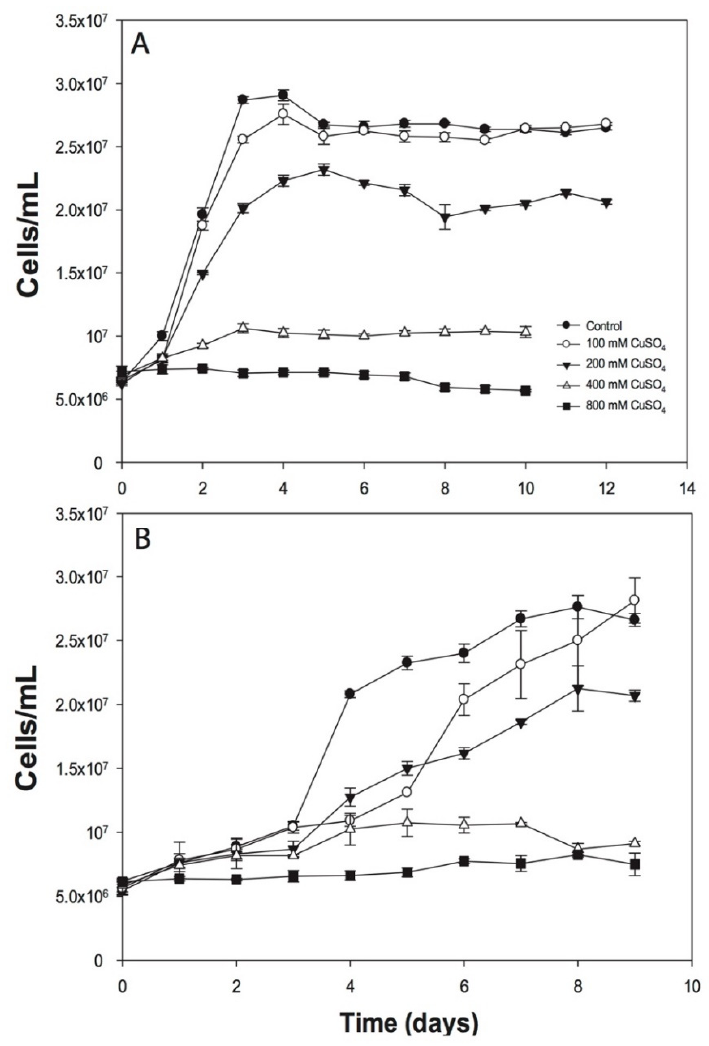
Figure 1. Growth of A. ferrivorans ACH in the presence of different CuSO 4 concentrations. Cells were incubated at 28 °C ( A ) and 10 °C ( B ). The mean values of three independent biological experiments (with three technical replicates each) were plotted.